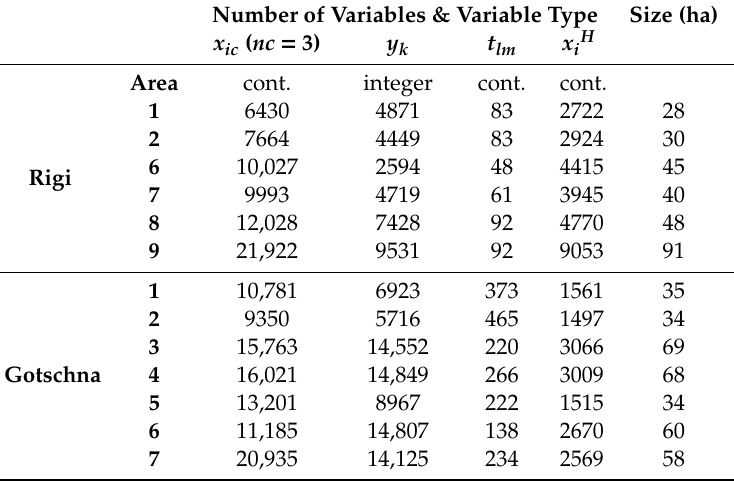
Table 4. Size and properties of the variables of the test areas. The variables have the following meaning: x ic : number of combinations to harvest a timber parcel (TP) (clustered with number of clusters = 3) y k : number of CR sections, t lm : number of landings, x iH : number of TPs. Number of Variables & Variable Type Size (ha) x ic ( nc = 3) y k t lm x iH Area cont. integer cont. cont. 1 Rigi